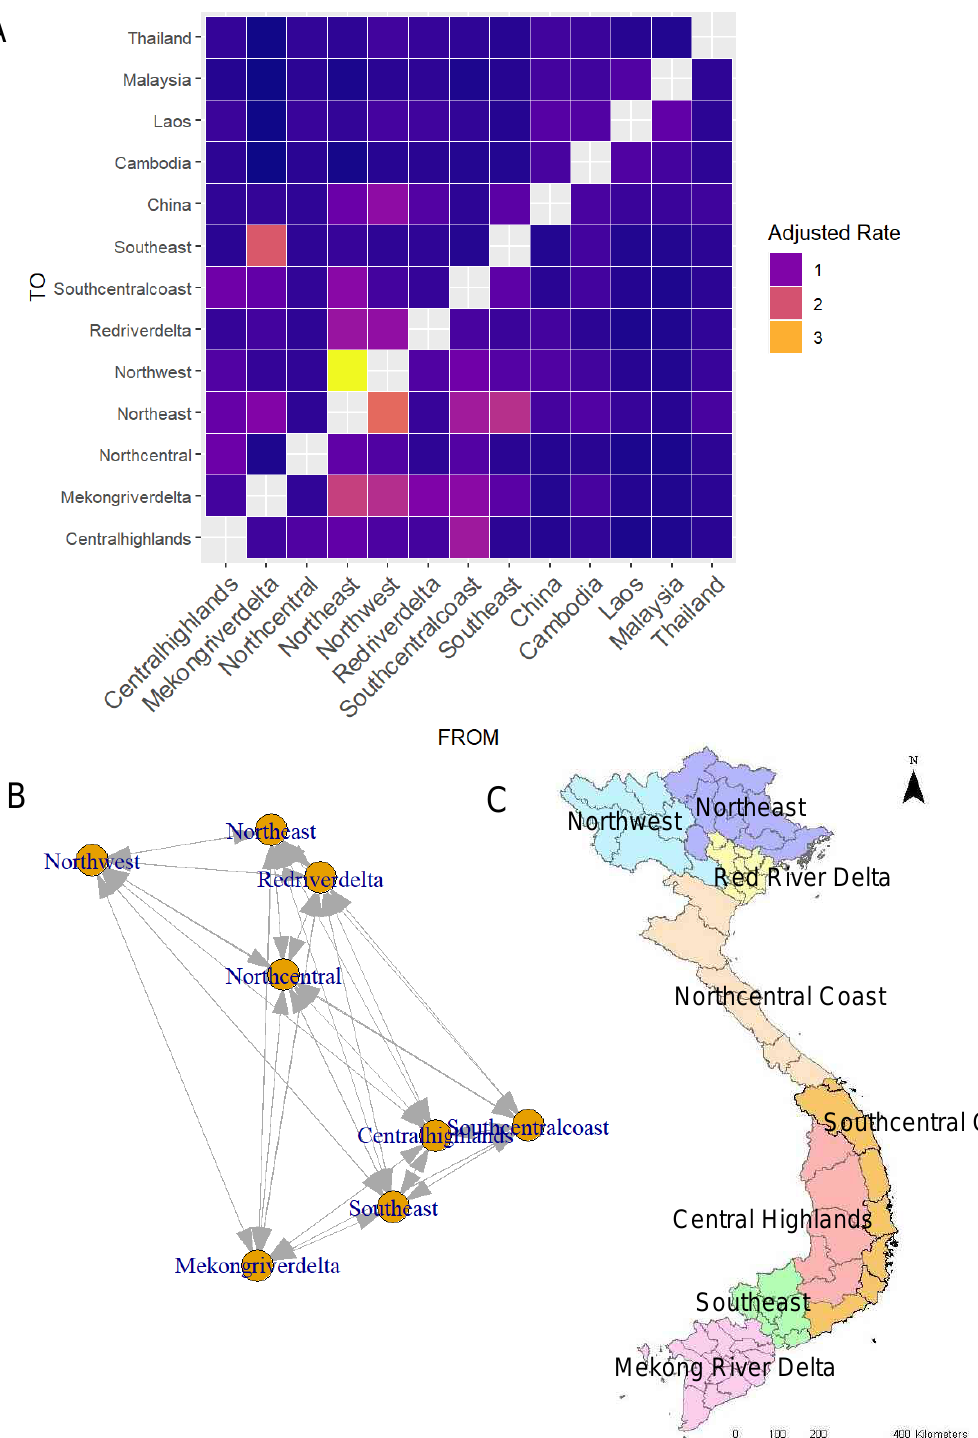
Figure 2. ( A ) The adjusted rate matrix for O/ME-SA/Pan Asia showing the virus movement between the different agricultural zones in Vietnam and the adjacent countries. The color gradient of the heat map indicates the adjusted rates, and colors closer to yellow show higher adjusted rates/higher movement compared to purple, which indicates lower adjusted rates/less movement. ( B ) Network of phylogeographically connected zones within Vietnam showing which regions are highly connected. ( C ) Map of agricultural zones in Vietnam that was used to create the network and the adjusted rate